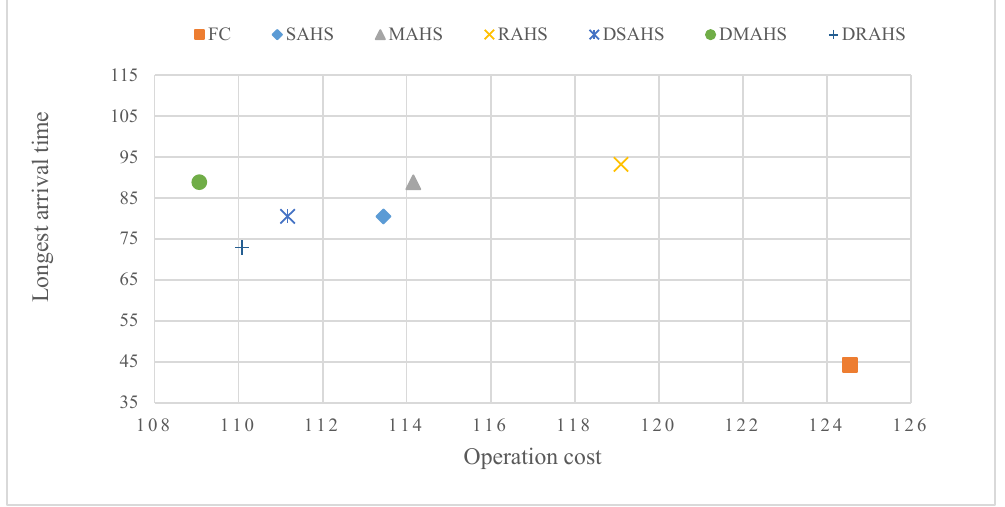
Fig. 5. Performance of these optimal networks